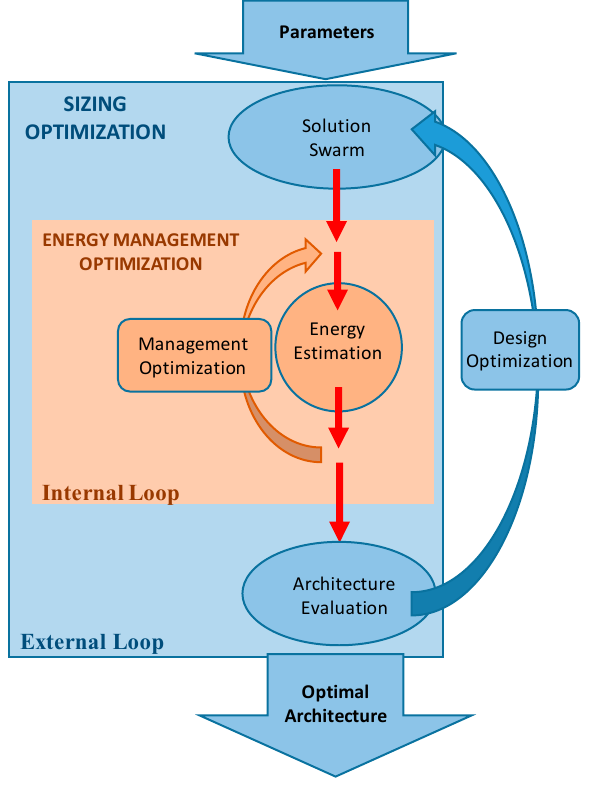
Figure 1. Overview of the suggested design optimization.